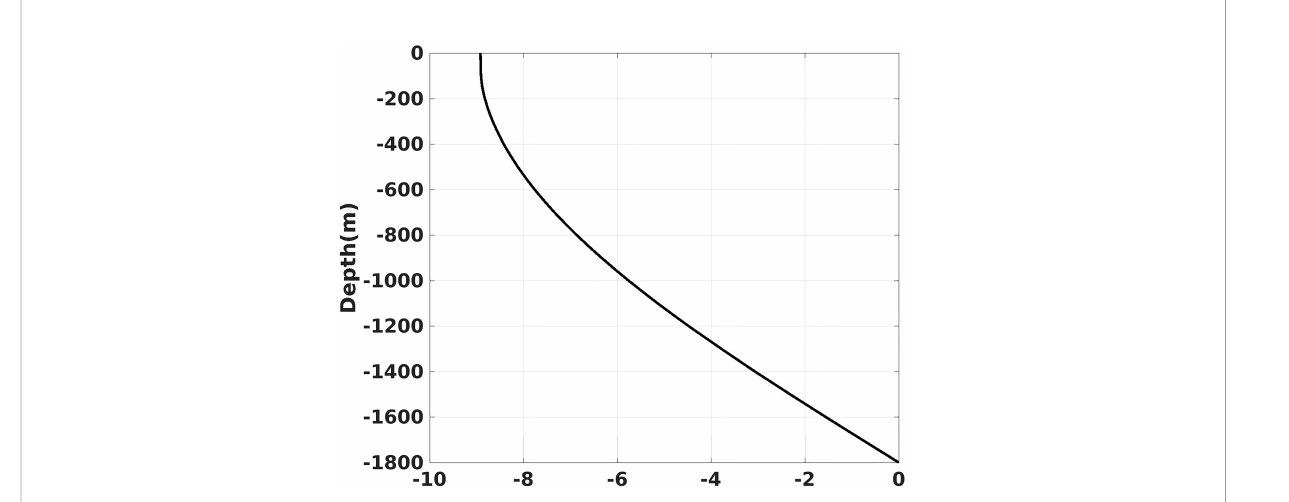
FIGURE 3 The vertical structure function J(z) of potential density of the idealized 3D